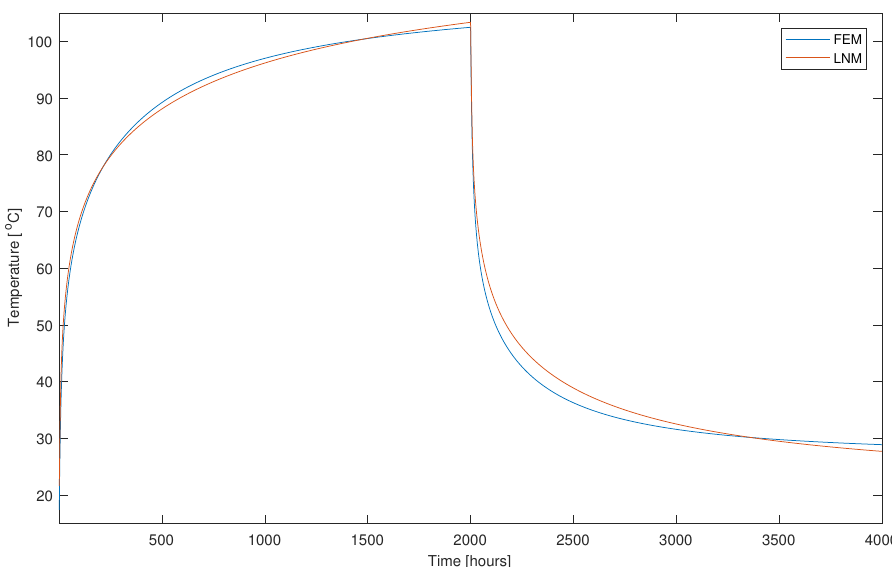
Figure 18. Transient temperature response to a full-load no-load current step for COMSOL Multiphysics finite element method (FEM) validation of a 220 [kV] 3 × 1800 [mm 2 ] Al XLPE SL-type submarine